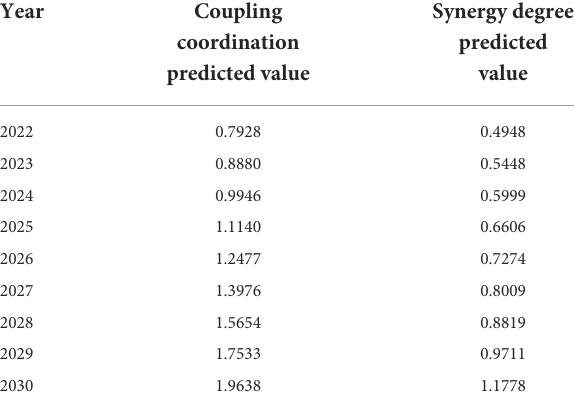
TABLE 12 Prediction results of coupling coordination level and synergy degree of low-carbon development in Anhui province from 2022 to